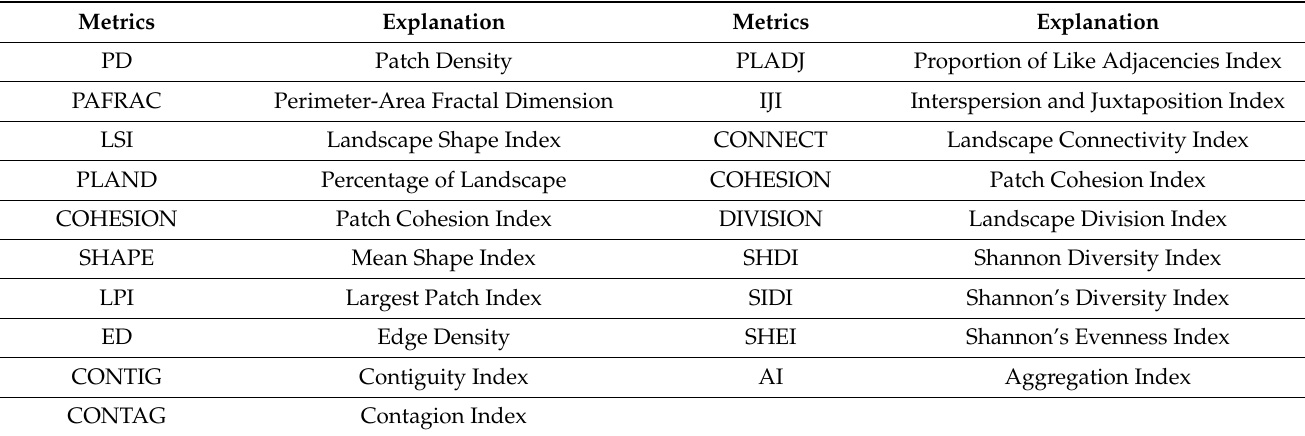
Table A1. The name and interpretation of the landscape pattern index used in the research.